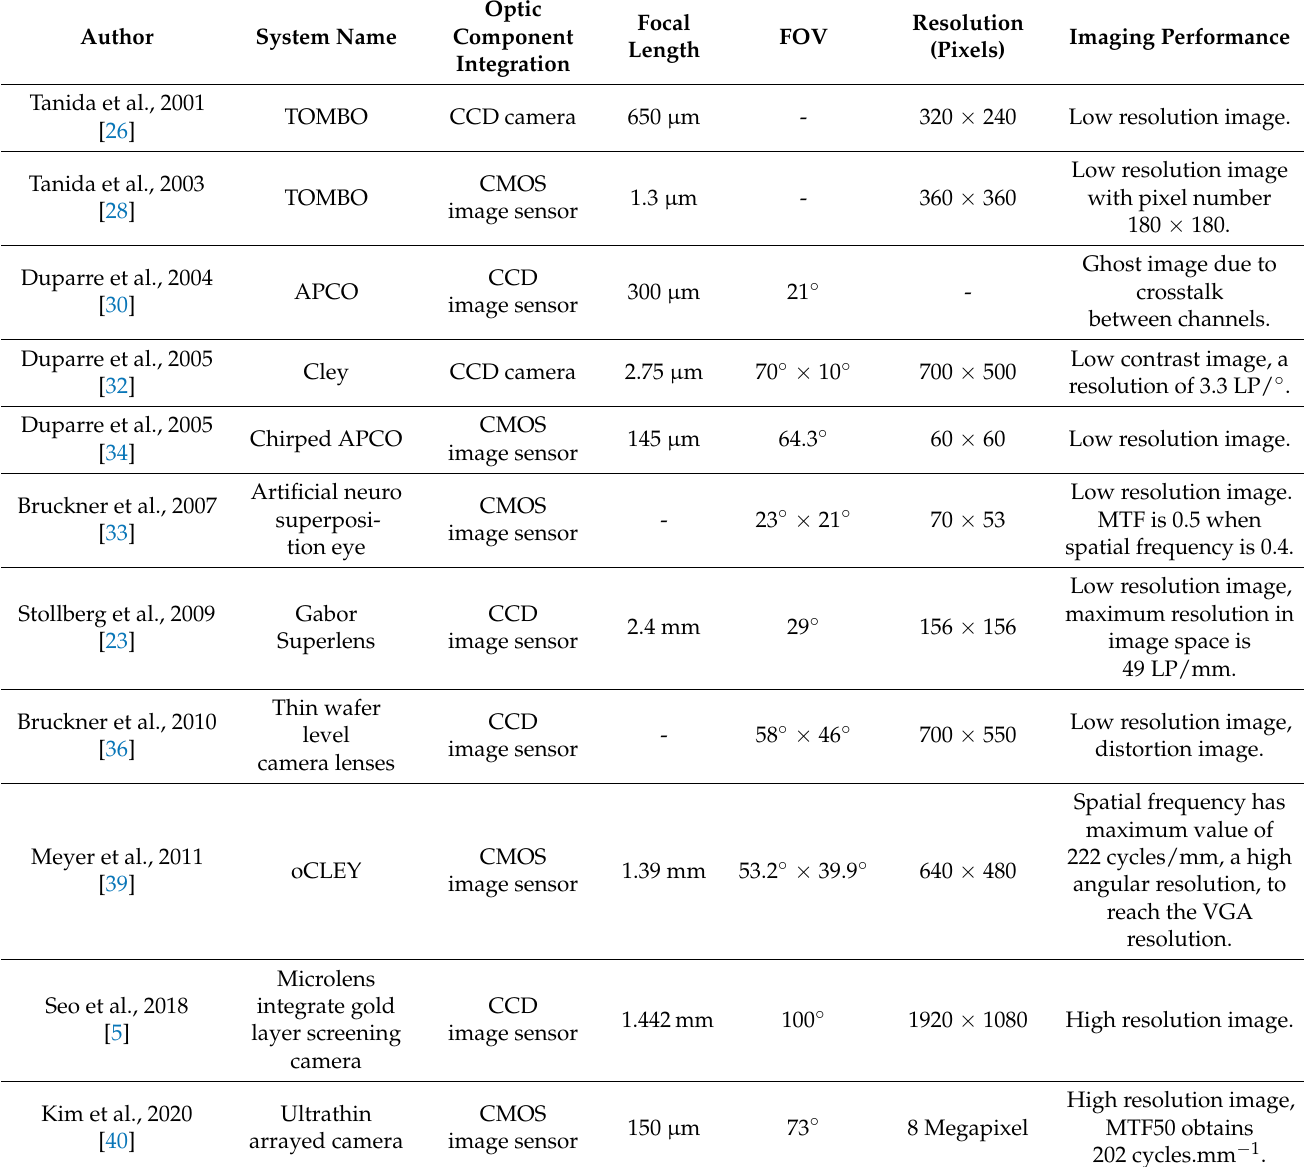
Table 2. The parameters and performance of the planar-type artificial compound eye